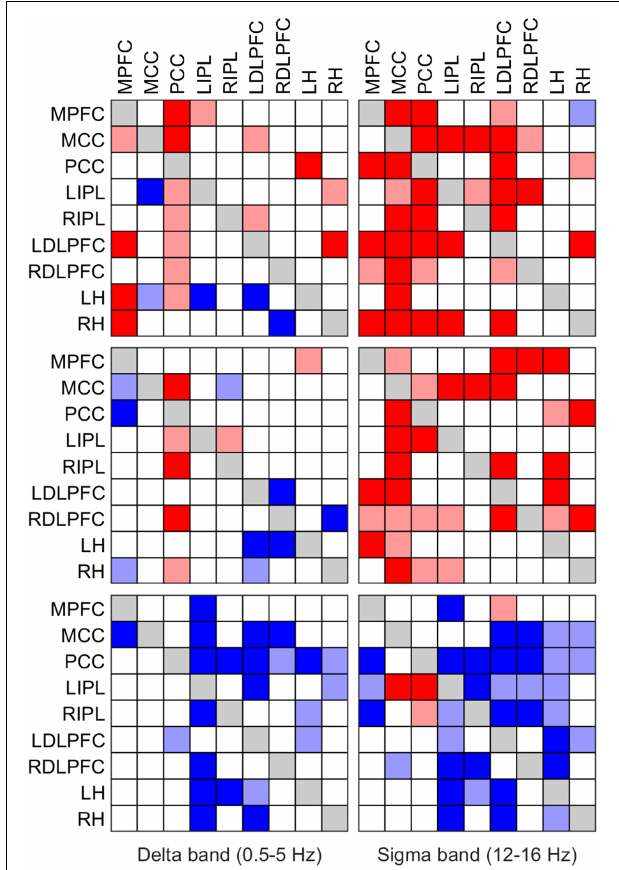
FIGURE 4 | Significant change of iCOH (connectivity) in the delta (left column) and sigma band (right column) at the SOn transition in baseline (top) and recovery (middle) and after SOn between baseline and recovery (bottom). Significant differences between conditions are plotted in matrix fashion; columns represent “senders”, rows are “receivers” of information flow. For the abbreviations of the ROIs see Table 1 . Red squares (light and dark) indicate connectivity before SOn < connectivity after SOn (top two rows) and connectivity at baseline < connectivity at recovery (bottom row); blue squares (light and dark) indicate the opposite change. Two significance thresholds were applied to reveal the hierarchy of changes: the lighter colors correspond to p < 0.05 (SnPM), the darker ones to p < 0.025